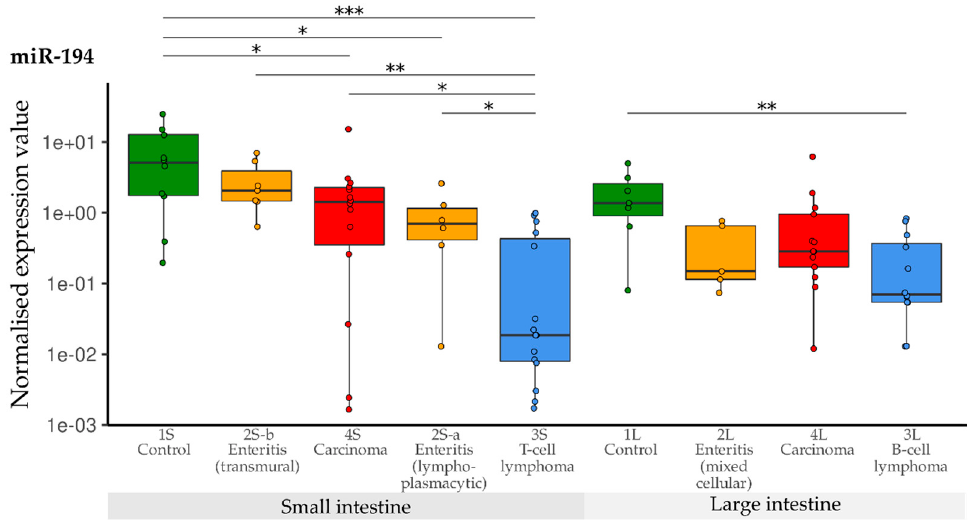
Figure 8. Expression levels of miR-194 in different groups (control, enteritis, carcinomas, lymphomas of the small and large intestine). The absolute miRNA copy number was related to the internal normaliser RNU6B. Results are shown as normalised expression values with a log10 scale. * p < 0.05, ** p < 0.005, *** p < 0.0005. Green control group, yellow enteritis, red carcinoma, blue lymphoma.